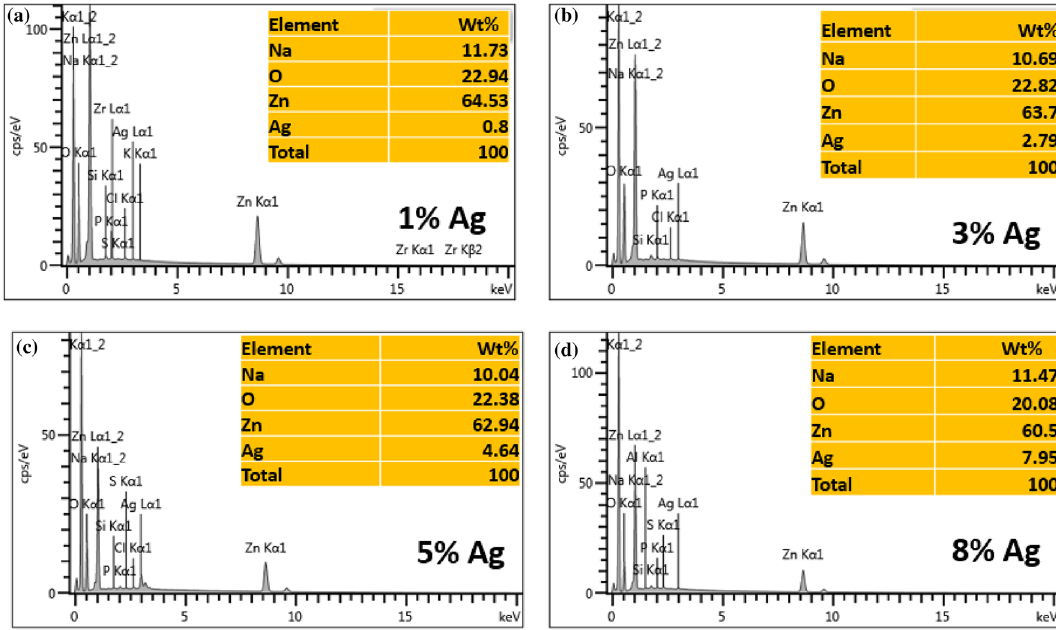
Figure 5. EDX spectra of ( a ) 1%, ( b ) 3%, ( c ) 5%, and ( d ) 8% Ag–ZnO